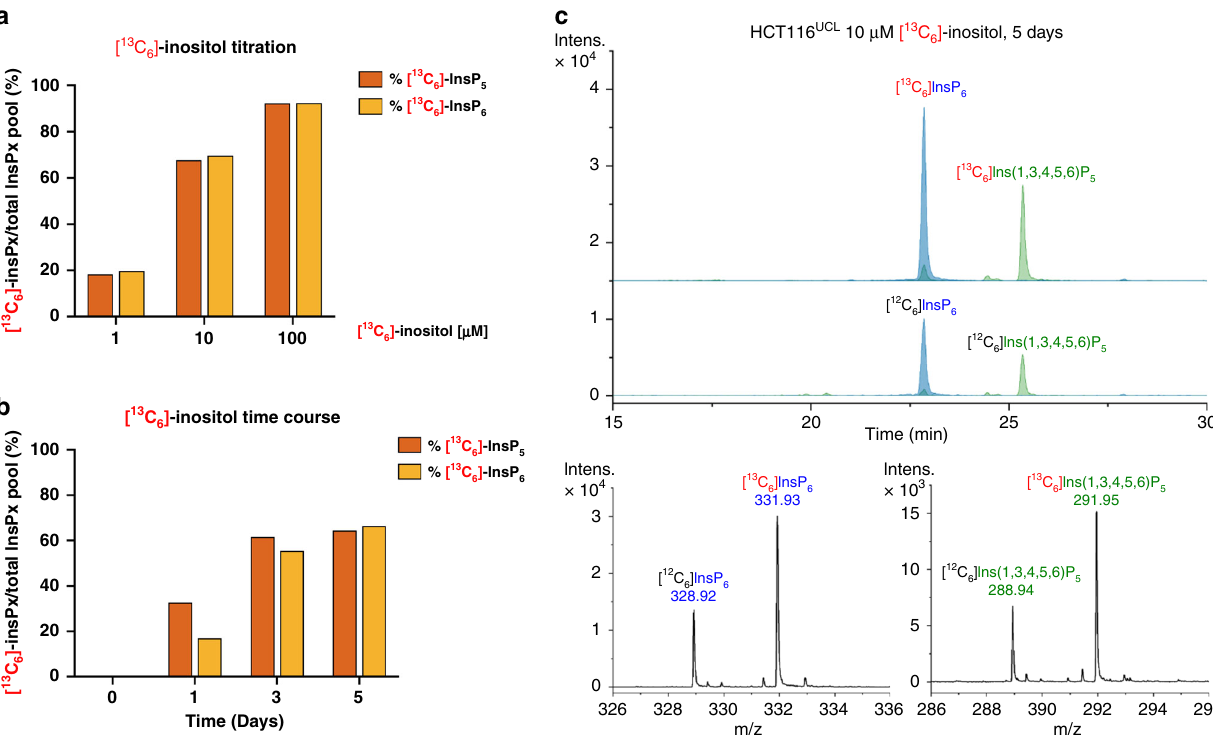
Fig. 5 CE-ESI-MS analysis after [ 13 C 6 ]-inositol labeling. a Ratio of [ 13 C 6 ]InsP x ( x = 5 or 6) over total InsP x ([ 13 C 6 ]InsP x + [ 12 C 6 ]InsP x ) pool in wild-type HCT116 UCL after 5 days incubation with different concentrations of [ 13 C 6 ]-inositol (1, 10, 100 μ M) in inositol-free DMEM. b Ratio of [ 13 C 6 ]-InsP x in total InsP x pool in wild-type HCT116 UCL cells incubated with 10 μ M [ 13 C 6 ]-inositol in inositol-free DMEM for 1, 3, and 5 days. c EIEs of InsP 6 and Ins(1,3,4,5,6)P